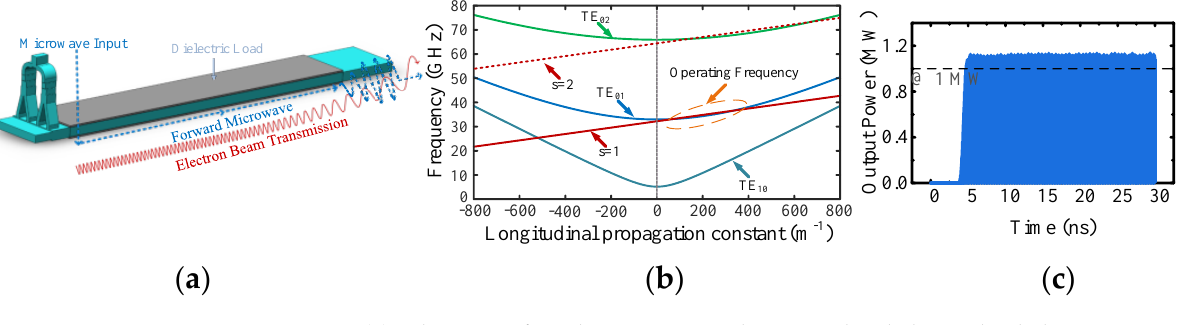
Figure 1. ( a ) Schematic of mode converter and rectangular dielectric-loaded interaction circuit. ( b ) Beam-wave dispersion relations in rectangular gyro-TWT. ( c ) Output power as a function of time. As shown in Figure 1a, when the gyro-TWT is operating, the electron beam is